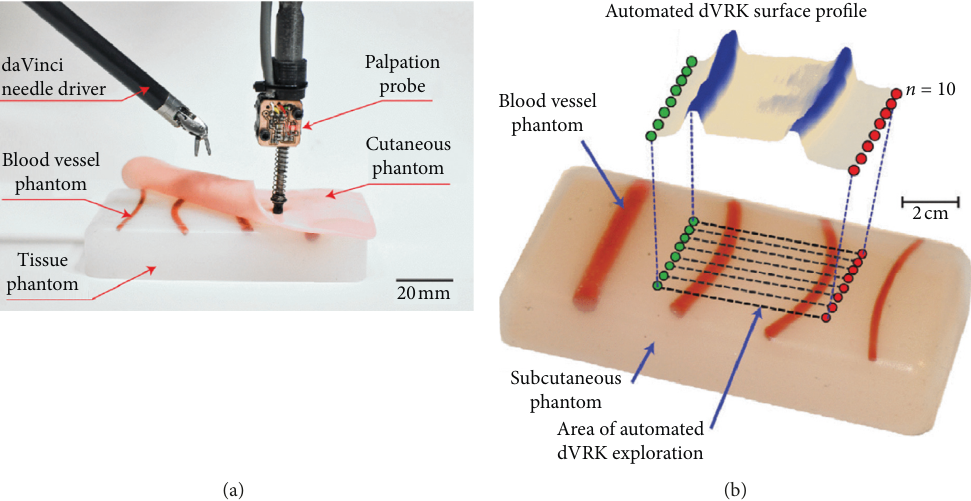
Figure 11: (a) Schematic illustration of disposable palpation mounted on da Vinci Research Kit (dVRK) needle tool. (b) Photograph shows the silicone tissue phantom with blood vessel inclusions and dermal phantom (adapted with permission from Ref. [110]; copyright 2015, IEEE publishing